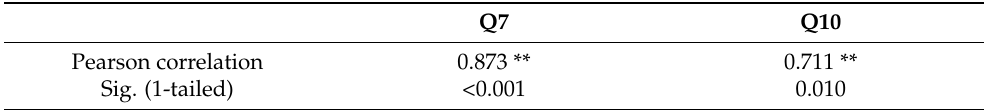
Table 8. Correlations between participants’ knowledge about recommender systems and answers of Q7 and Q10. Q7 Q10 Pearson correlation 0.873 ** 0.711 ** Sig. (1-tailed) <0.001 0.010